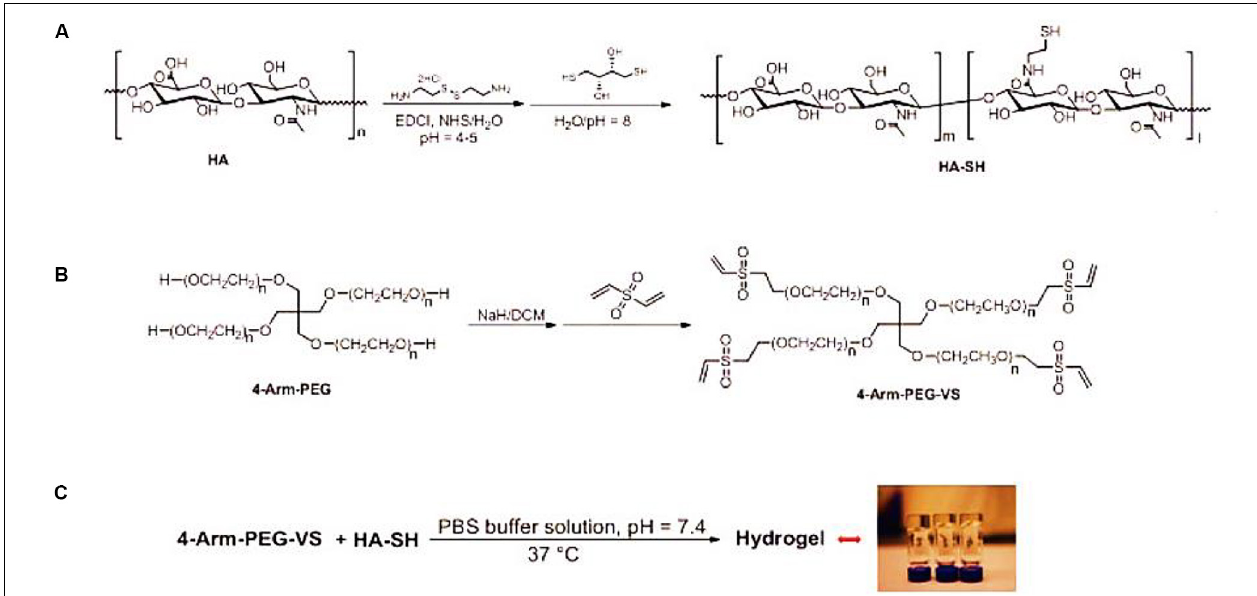
FIGURE 5 | (A) Schematics for synthesis of HA-SH from HA, (B) 4-arm-PEG-VS based on 4-arm-PEG, and (C) formation of the HA-PEG composite hydrogel via the Michael addition reaction between HA-SH and 4-arm-PEG-VS. Reproduced from Jeong et al. (2014) with permission from Copyright 2014